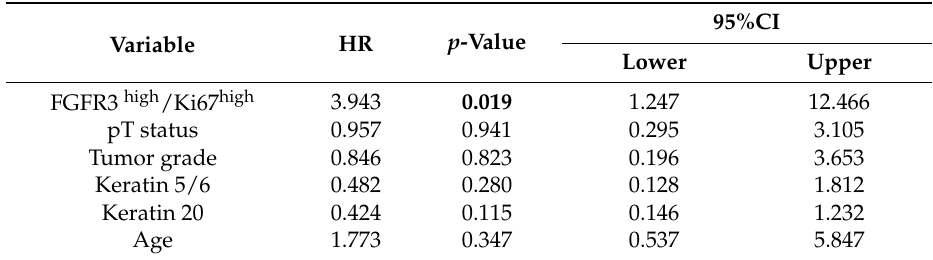
Table 3. Multivariate Cox regression analysis of immunohistochemical markers including all factors potentially influencing PFS.